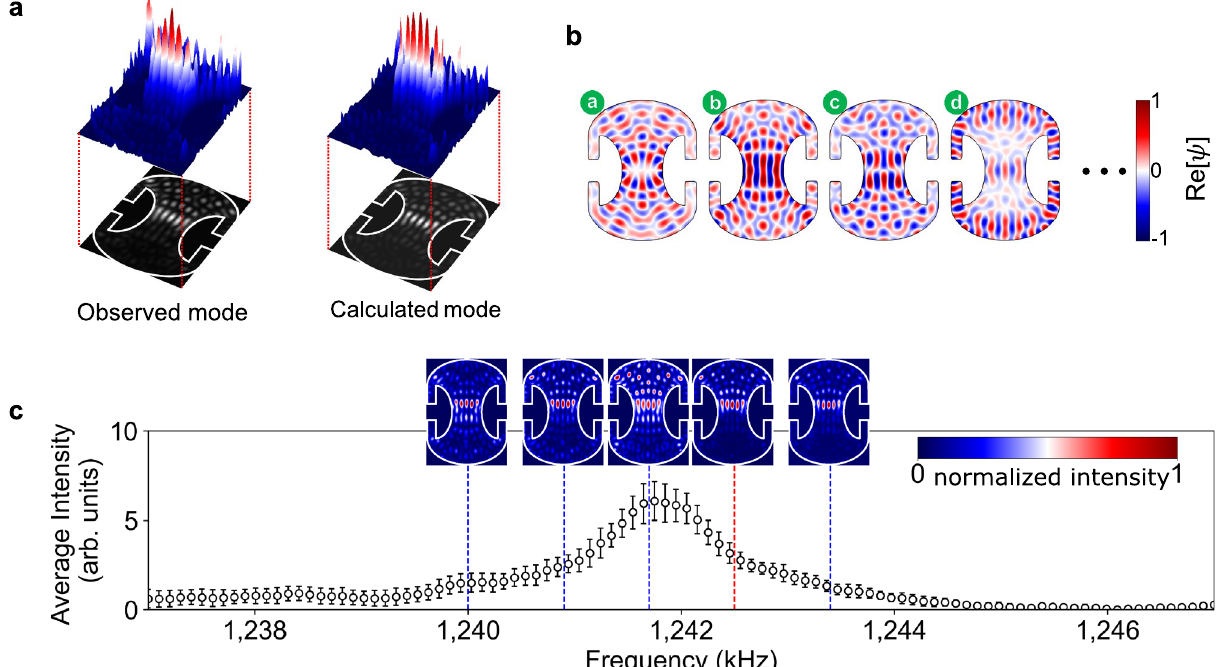
Figure 3. Numerical reproduction and the excitation spectrum of HIM. ( a ) The image of the HIM and the numerical reproduced one from superposition of near-degenerate resonant modes. The white solid lines represent the boundary between aluminum and water. Animation is also available (Supplementary Movie 1). ( b ) The mode patterns of the four near-degenerate resonant modes most contributing to HIM. The real parts of the field distributions of complex eigenstates in the fluid region inside the Penrose cavity are shown. ( c ) The excitation spectrum of the HIM (black open circles). The error bar indicates one-standard deviation at each sample mean. Mode patterns at five representative frequencies are also shown. The red dotted vertical line indicates the frequency at which the HIM is